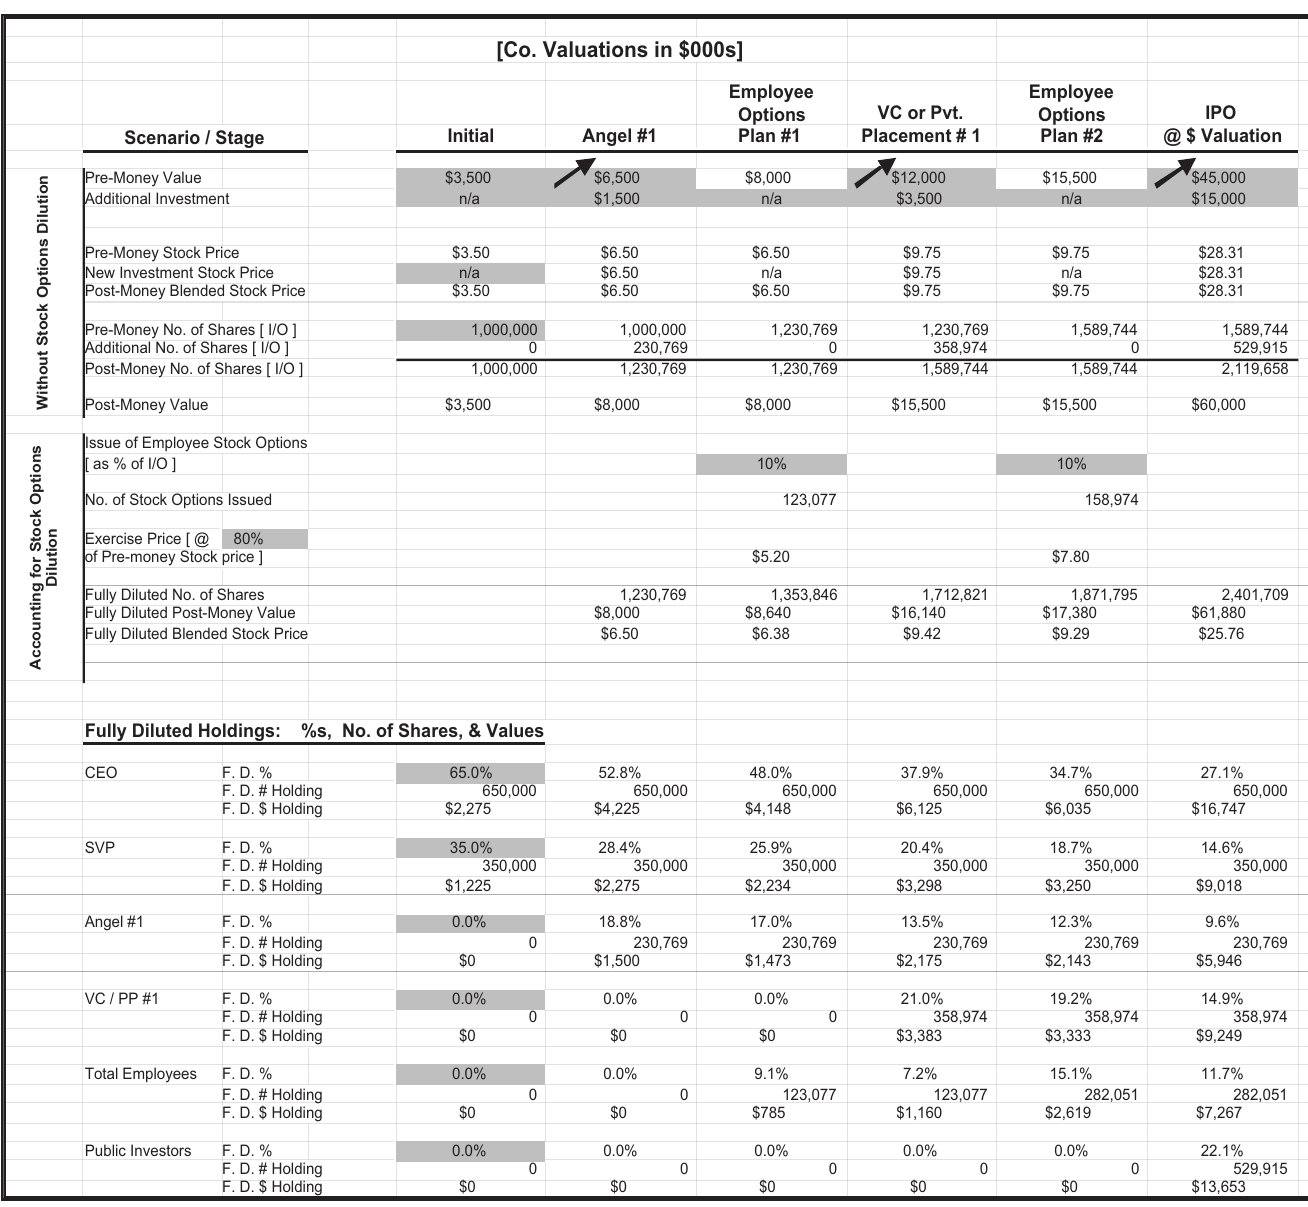
Table 1. Simple Equity